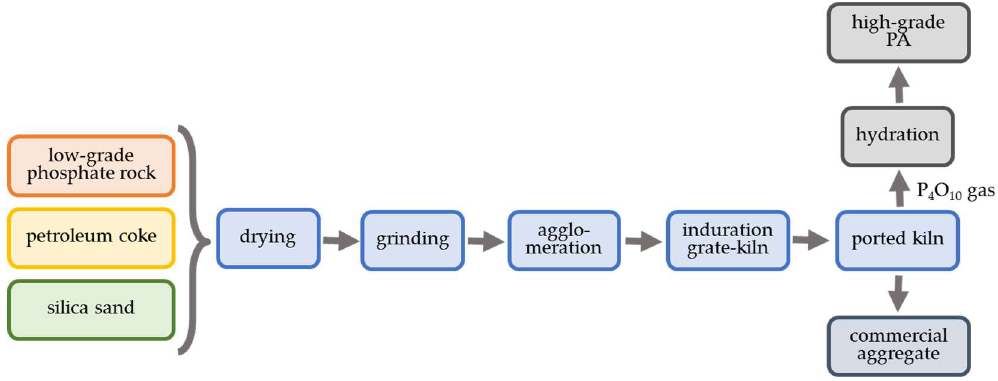
Figure 5. IHP flowchart with pretreatment kiln (based on [84]).